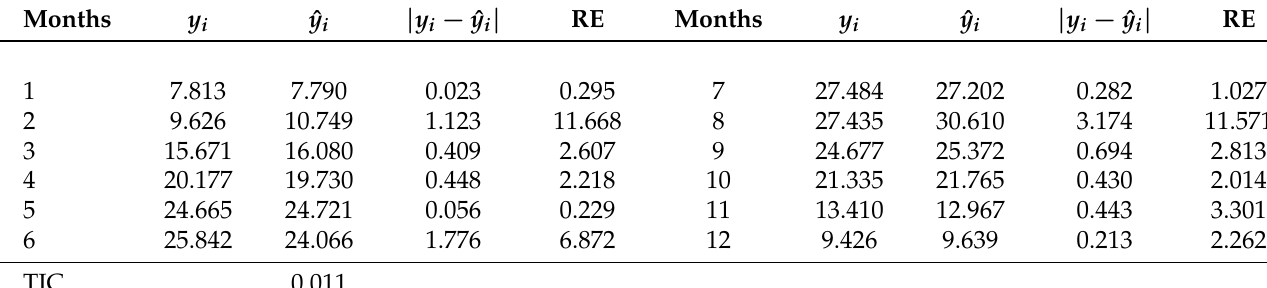
Table 3. Fitting results ˆ y i of the Model VI based on Huber’s function (during fitting interval,